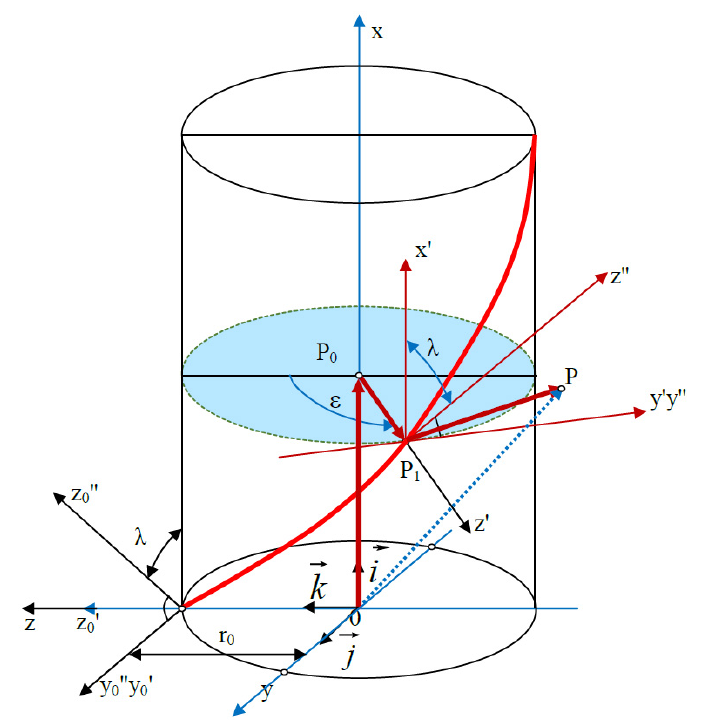
Figure 1. Vector of helical surface.